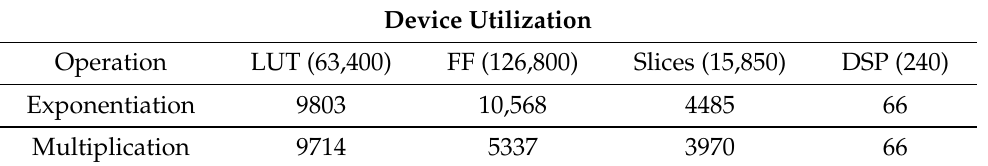
Table 5. Resources used by the FPGA for the proposed Modular Multiplication.